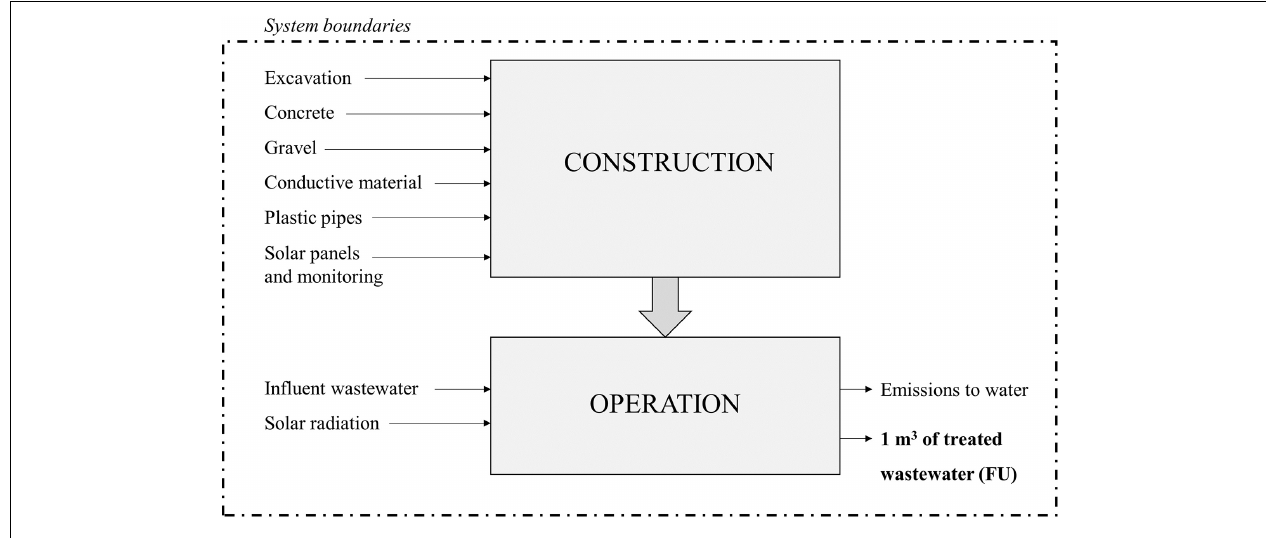
FIGURE 3 | System boundaries for the LCA of the METland R (cid:13) designs.